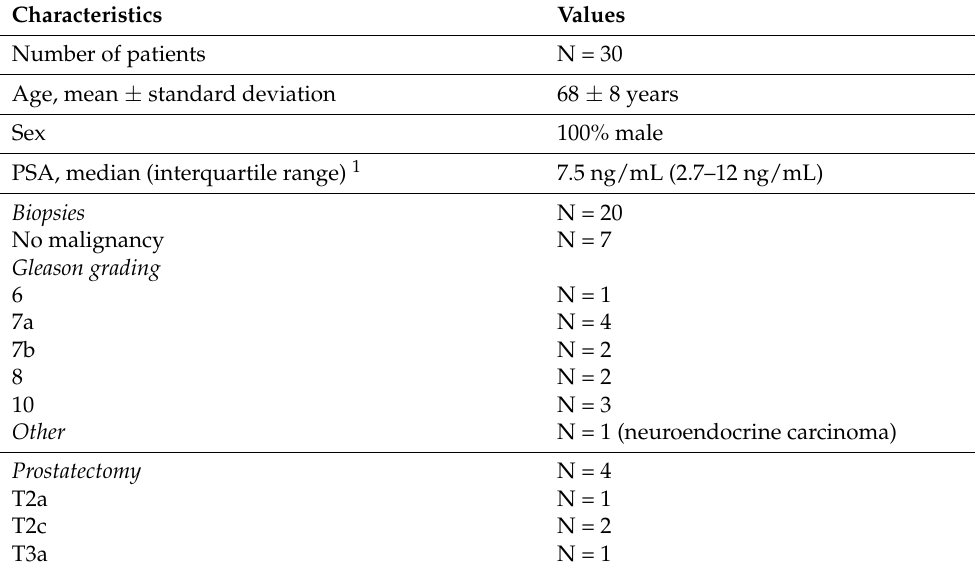
Table 2. Patients’ characteristics.